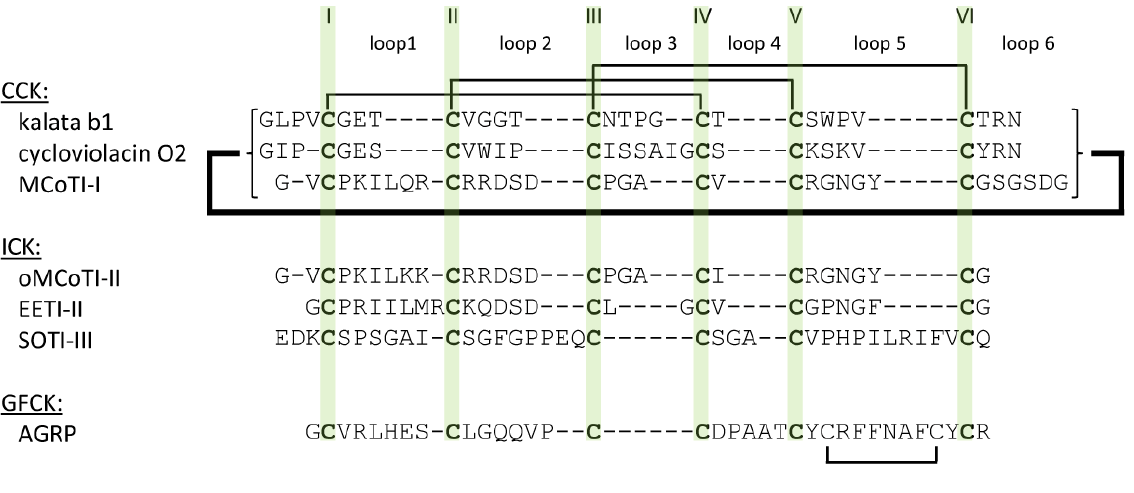
Figure 2. Sequence alignment of certain cystine knots. Cystine connections as well as head-to-tail macrocyclization motif are